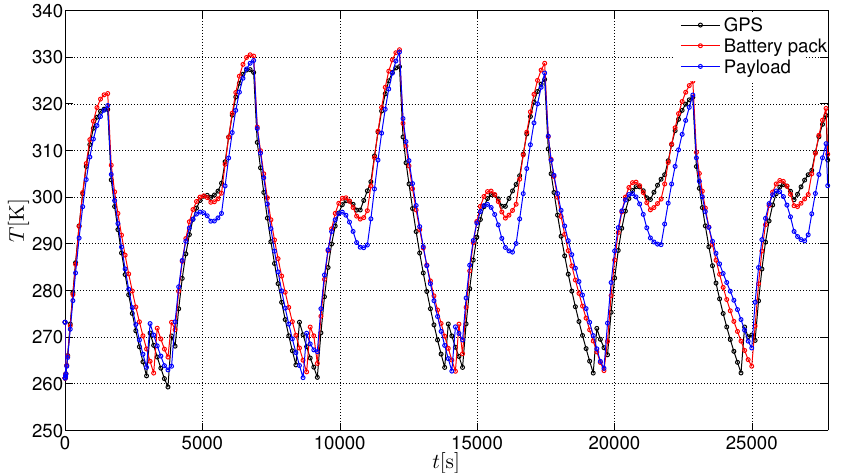
Figure 8. Average temperature in the electronic boards as function of time ( β = 57 ◦ ).